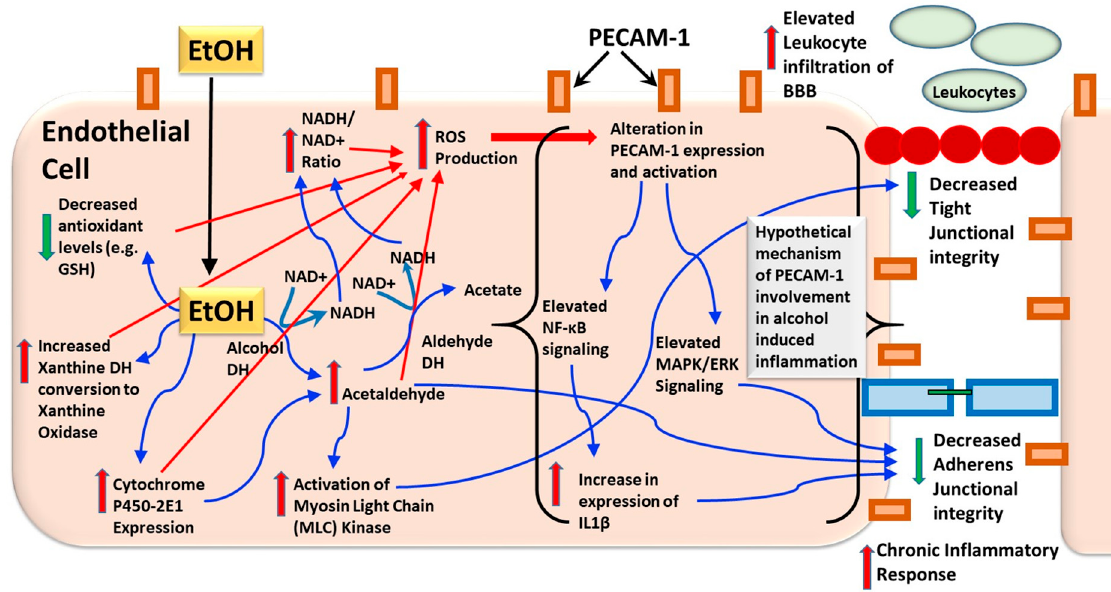
Figure 2. Schematic of an endothelial cell in the periphery with expression of PECAM-1 and alterations in signaling and expression of proteins by alcohol (EtOH) experience. Blue arrows indicate direct actions of EtOH in the cell, red arrows indicate secondary actions of EtOH in the cell. Hypothetical involvement of PECAM-1 in alcohol-induced inflammatory signals is indicated in brackets in the endothelial cell.